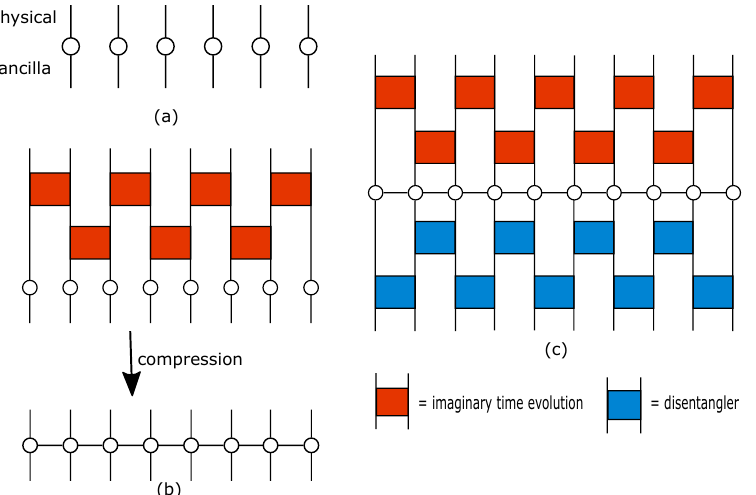
Figure 8. (a) The initial TFD; (cid:12) = 0 MPS is a trivially entangled state. (b) After the application j i of the time evolution operator (red boxes, Trotter decomposed on to even an dodd bonds) on to the physical legs, the MPS is compressed following the usual TEBD algorithm as and results in an MPS with entanglement. After this step, we perform the disentangling sweep as described in the text. (c) The (cid:12)nal form of tensor network produced by our algorithm after a single iteration.